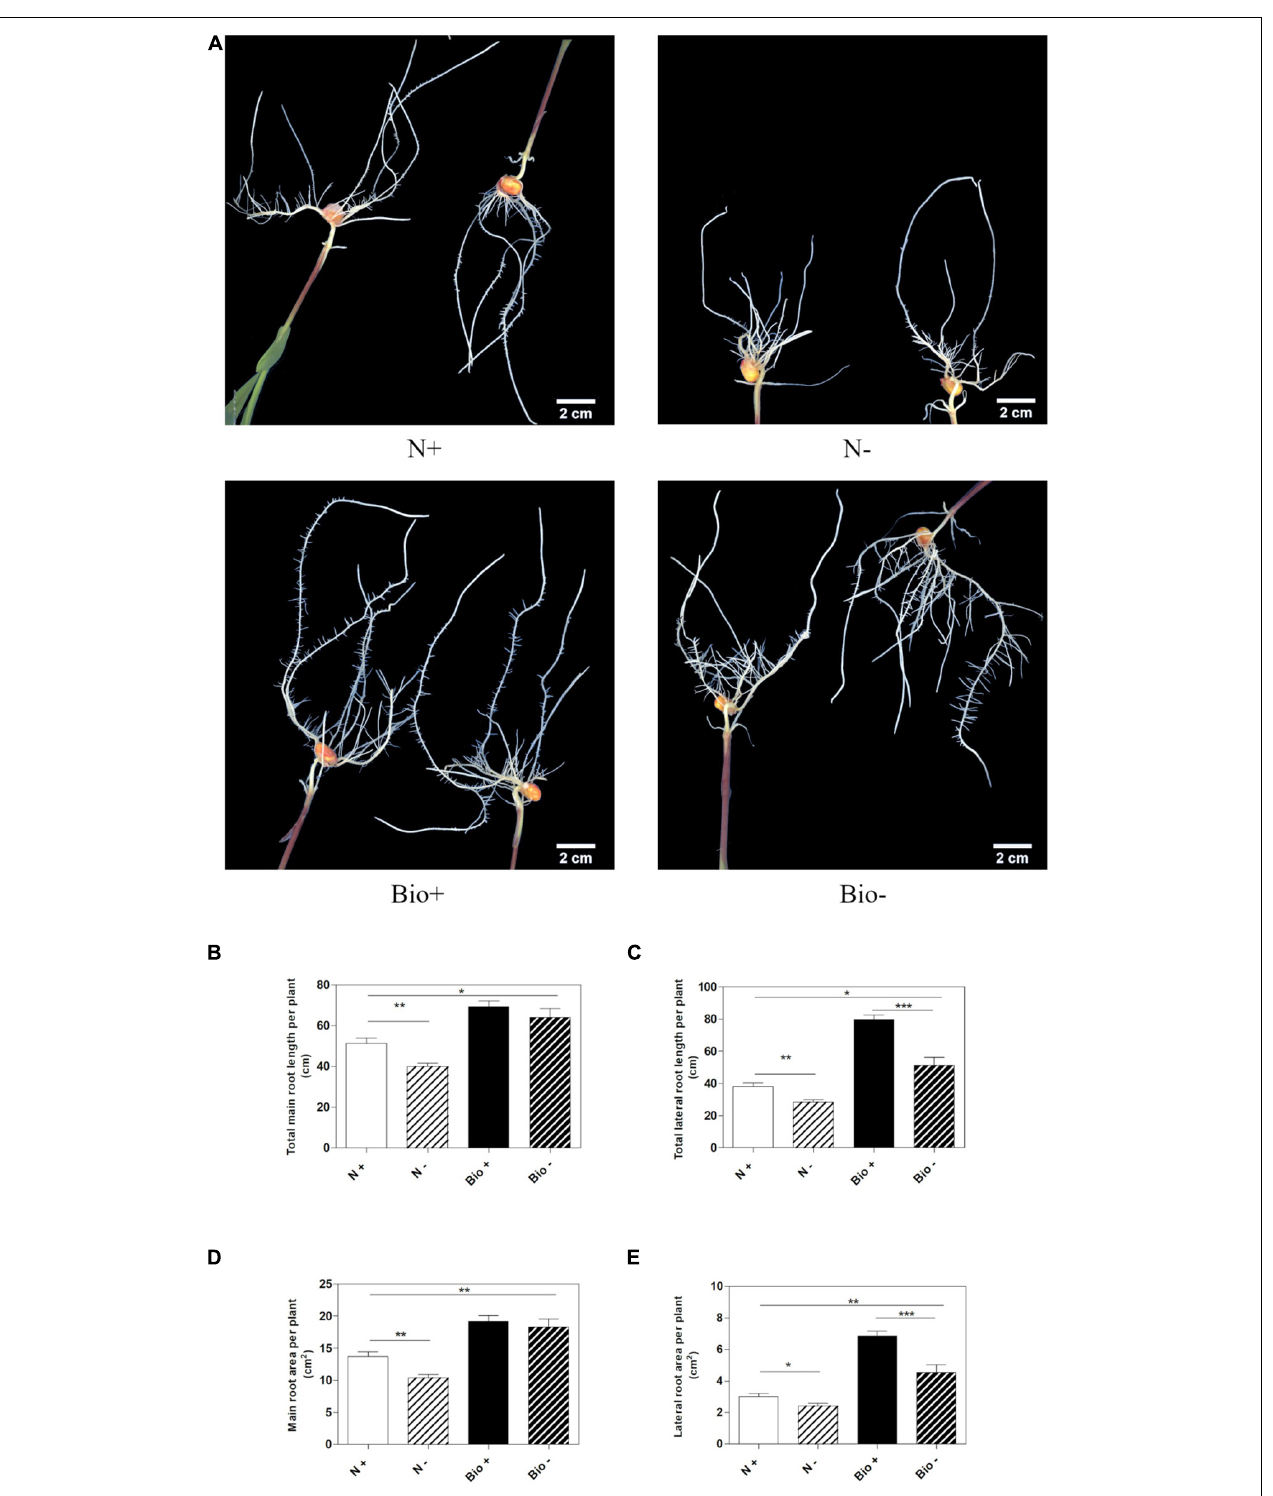
FIGURE 2 | Effects of the PH on root growth of maize plants subjected to hypoxic stress. Maize plantlets grown with (+) or without (–) air insufflation in the nutrient solution after 4 days of treatment with either 0.1 mL L − 1 PH (Bio) or with the equivalent amount of total N (14.3 mg L − 1 ), supplied as inorganic nitrogen (N) (A) . Total seminal and primary root length (B) , total lateral root length (C) , total seminal and primary root area (D) , and lateral root area (E) , of the maize plantlets treated as described above. Root length and root area were measured with WinRHIZOTM software. Mean values per plant are reported. Bars represent the standard error (SEM) ( n ≥ 22), Student’s t -test was applied, * p < 0.05; ** p < 0.01; *** p < 0.001.